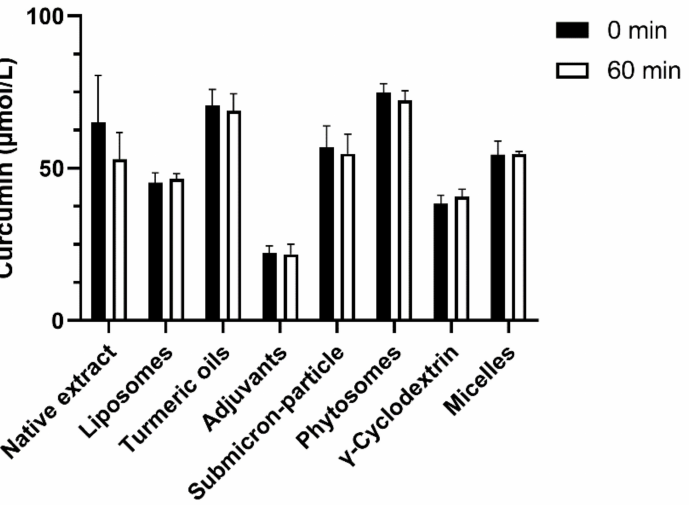
Figure 3. Curcumin concentrations ( µ mol/L) were quantified in MEM Complete, before and after 60 min, at 37 ◦ C and 5% CO 2 in the absence of cells to investigate curcumin stability. Data are presented as mean ± SD. All experiments were conducted in biological triplicates ( n = 3) and technical duplicates. No significant differences at p < 0.05 were observed within each formulation between 0 min and 60 min (unpaired t